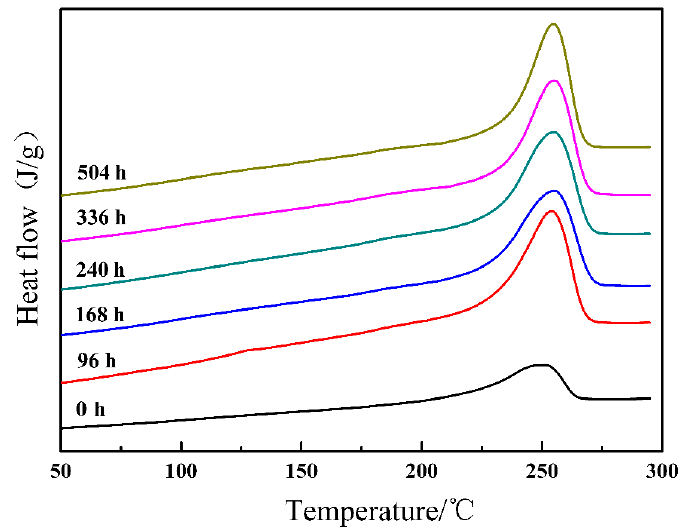
Figure 6. Typical melting thermograms for irradiated ETFE at 180 kGy against aging time. Table 2. Non-isothermal DSC scan results for the samples irradiated at 180 kGy at various aging times.